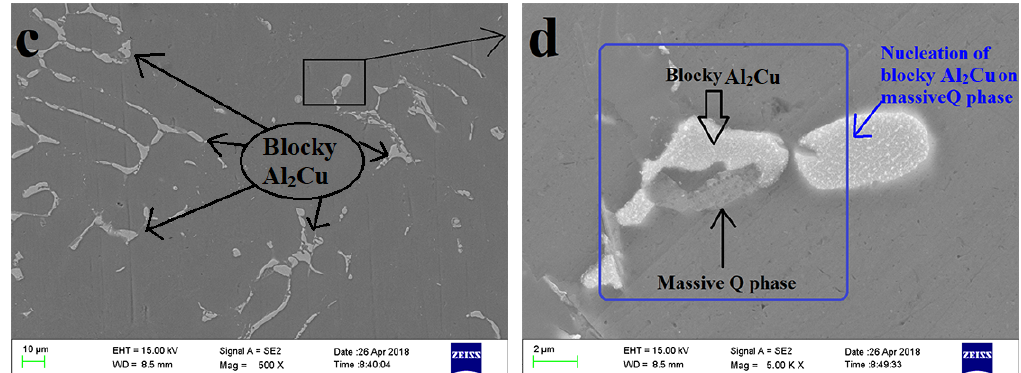
Figure 2. Microstructure of the AlSi9Cu3Mg0.2 and AlSi9Cu3Mg0.6 alloys in the as-cast conditions. ( a ) The morphology and size of Al 2 Cu in the AlSi9Cu3Mg0.2, ( b ) amplification of ( a ) red rectangular area, ( c ) the morphology and size of Al 2 Cu in the AlSi9Cu3Mg0.6, and ( d ) amplification of ( a ) black rectangular area.